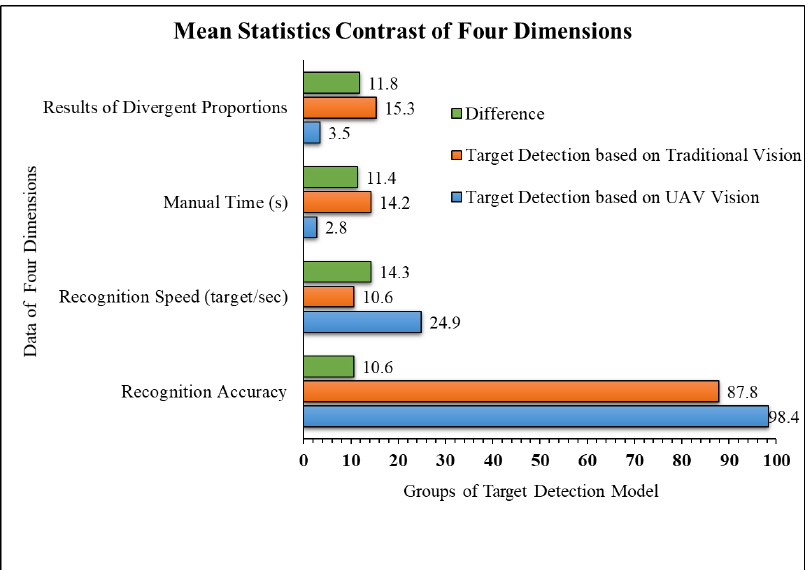
Figure 4. Average comparison of target detection based on UAVs and traditional